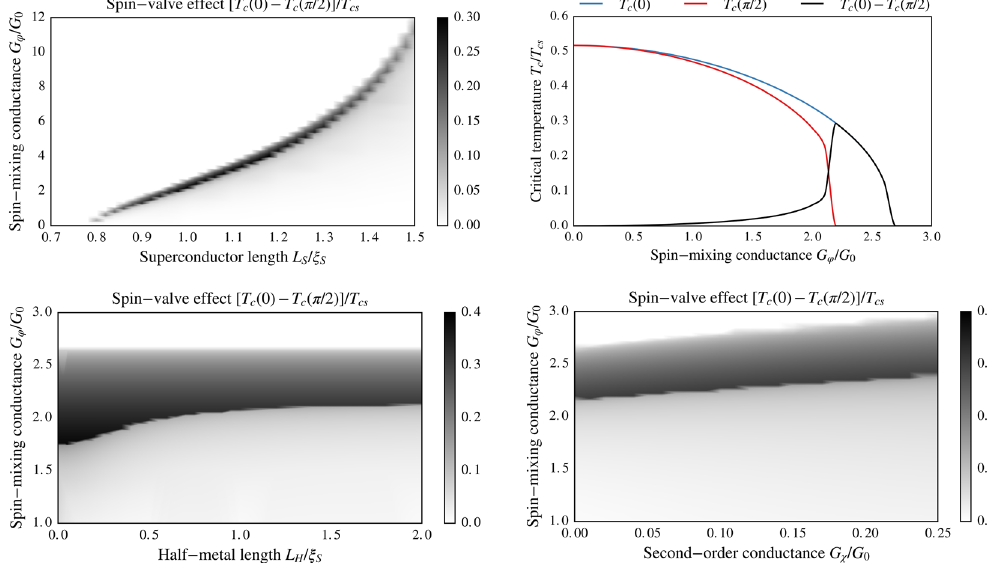
Figure 10. Plots of [ T c (0) − T c ( π /2)]/ T cs , where T c ( α ) is the critical temperature of an S/HM bilayer with an interfacial magnetic misalignment α , and T cs is the critical temperature of a bulk superconductor. Top left: We fixed the halfmetal length to 12 ξ S , and varied the superconductor length and spin-mixing conductance. Above the black region, i . e . for small superconductors or strong spin-mixing, we see both T c ( π /2) and T c (0) go to zero. Below the black region, i . e . for large superconductors and weak spin-mixing, both T c ( π /2) and T c (0) converge to the same finite value. The black curve delineates a critical region where T c ( π /2) drops to zero while T c (0) remains finite, leading to a very large difference. Top right: We fixed the halfmetal length to 12 ξ S and the superconductor length to 1 ξ S , and highlight how T c (0) and T c ( π /2) behave. This illustrates why the top-left curve looks like it does. Bottom left: We fixed the superconductor length to 1 ξ S , and varied the halfmetal length and spin-mixing conductance. We also checked lengths L H up to 12 ξ S and find that the halfmetal length is essentially irrelevant for L H > 2 ξ S . Bottom right: We fixed the superconductor length to 1 ξ S and halfmetal length to 12 ξ S , and varied the 2nd order conductance G χ and spin-mixing conductance G ϕ . We see that the 2nd order terms basically produce a quantitative shift of the transition region towards higher values of G ϕ , but does not appear to qualitatively change